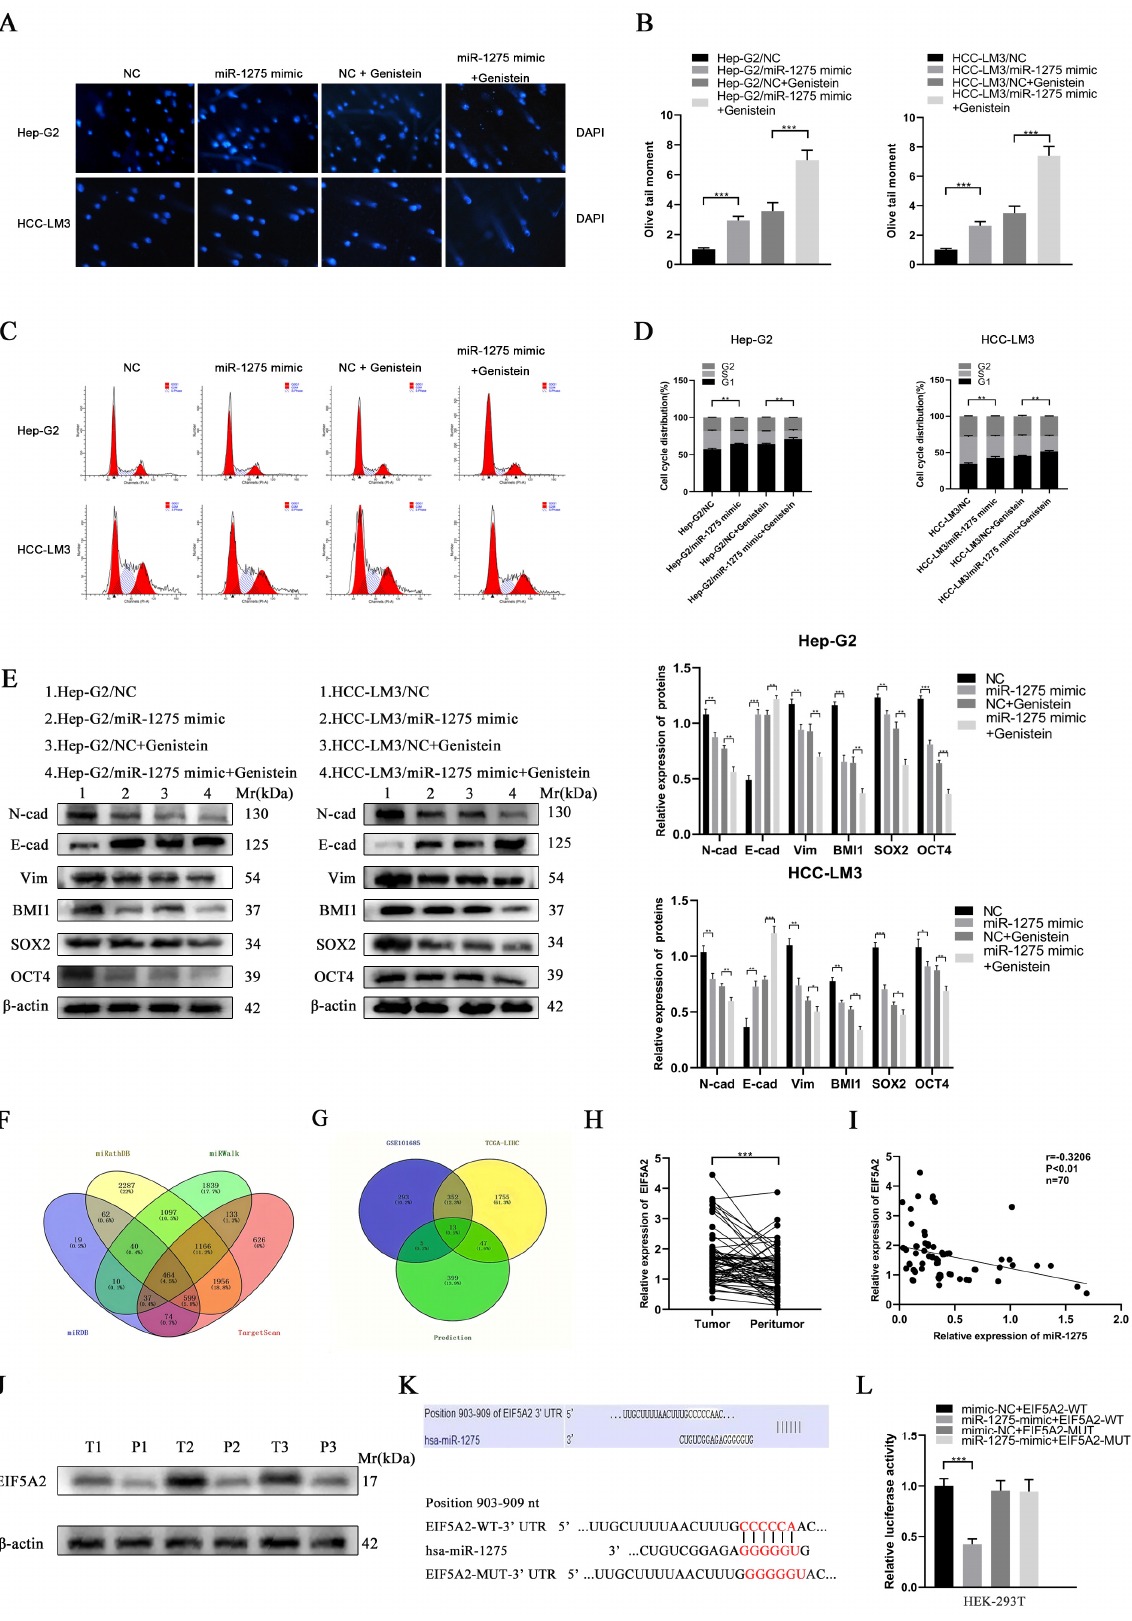
Figure 3. Genistein upregulated miR-1275 to suppress the EMT and stemness of HCC cells through the targeted inhibition of EIF5A2. ( A , B ) Comet Assays for evaluating the DNA damage and apoptosis of Hep-G2 and HCC-LM3 cells in four groups: NC, miR-1275 mimic, NC + genistein